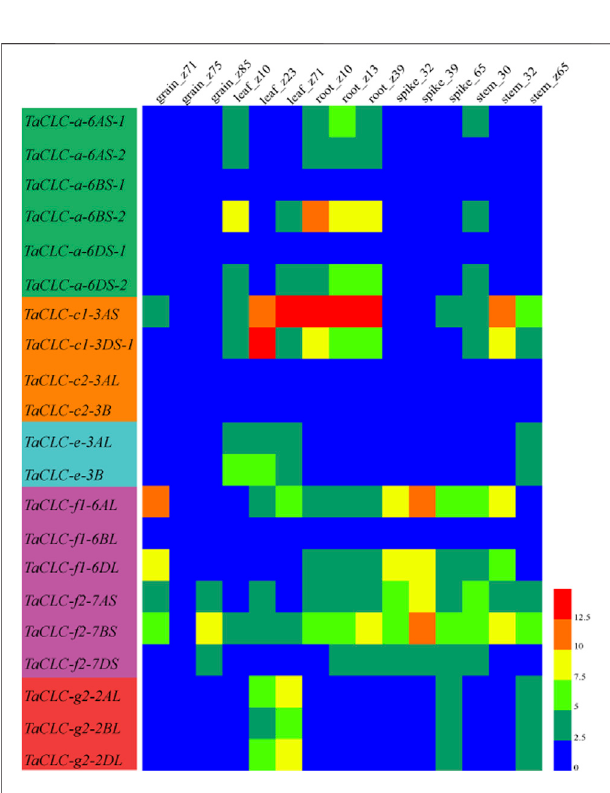
FIGURE 6 | Heat map of TaCLC genes expressed at different developmental stages in wheat tissues. The values were obtained from the RNA-seq data of Chinese spring wheat in different tissues and periods provided by WheatExp database (Pearce et al., 2015). The values of 0 – 12.5 represent the lowest to the highest expression levels of the detected